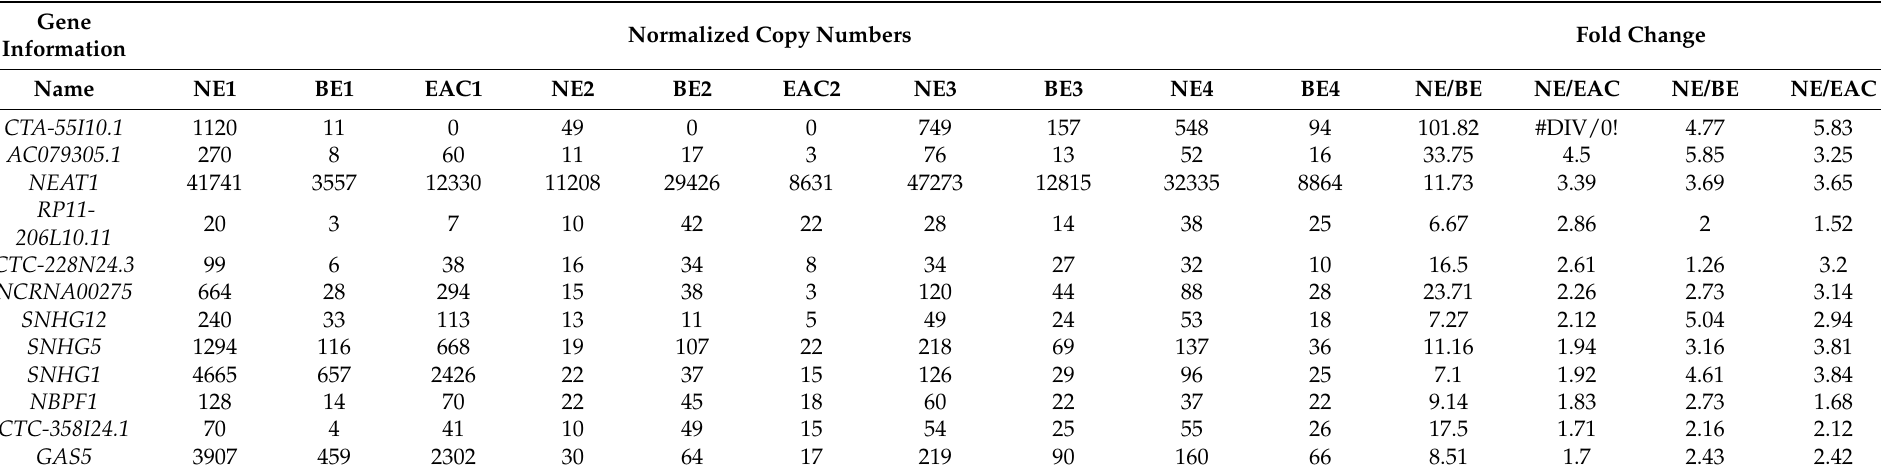
Table 2. Top 11 tumor-suppressive lncRNA candidates are sorted by the highest NE/EAC fold